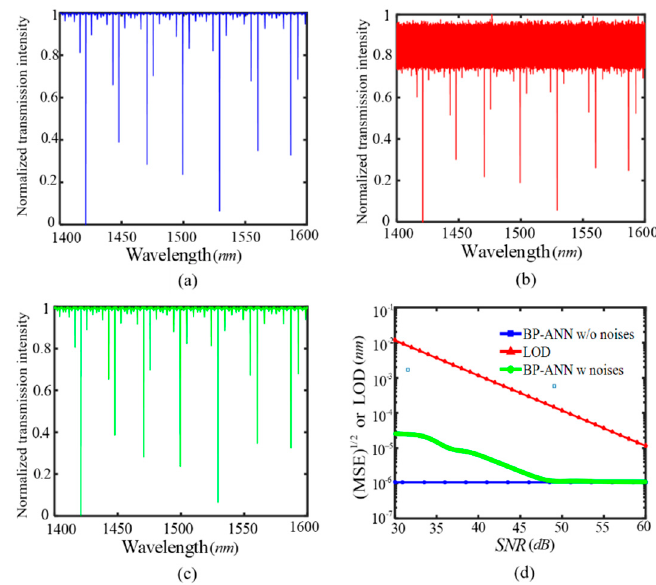
Figure 5. For the designed SIMRR sensor in Figure 1 ( a ), the simulated transmission spectra in the wavelength range of 1400–1600 nm at the length change of sensing arm waveguide l = − 10 nm ( a ) without noises, ( b ) with SNR = 15 dB, ( c ) with SNR = 30 dB. ( d ) The root-mean-square error (RMSE) of the measurement results by the BP-ANN and the LOD (limit of detection) of single mode dissipative sensing versus the SNR value.